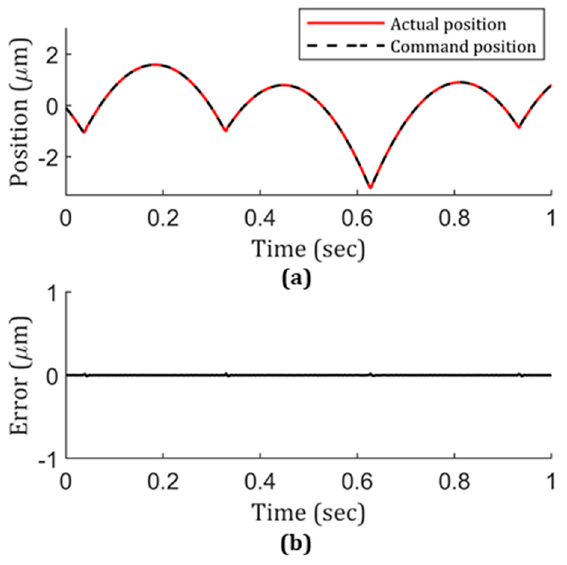
Figure 8. ( a ) Actual vs. command position on the z-axis of STS with a 0.004 s inverse time feed and a 2.5 µm constant-arc cutting condition and corresponding ( b ) position following error.